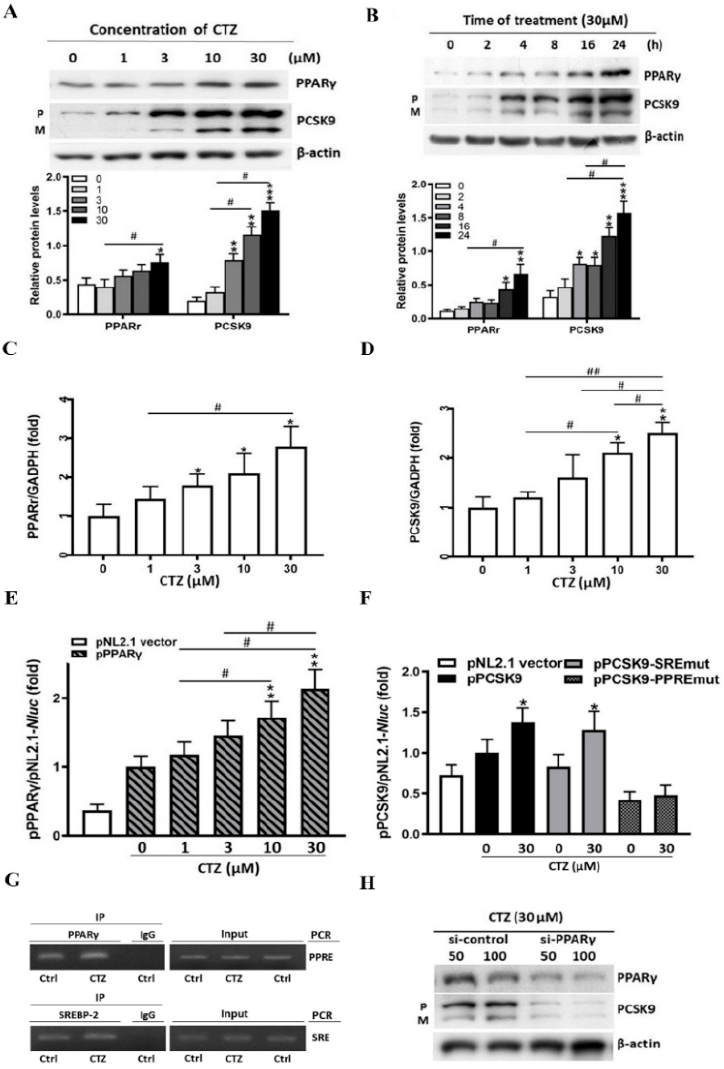
Figure 1. Cilostazol activates the expression of peroxisome proliferator-activated receptor- γ (PPAR γ ) and proprotein convertase subtilisin/kexin type 9 (PCSK9) in HepG2 cells. * p < 0.05, ** p < 0.01, and *** p < 0.001 versus the untreated group. # p < 0.05, and ## p < 0.01, comparison between treated groups. ( A ) HepG2 cells in serum-free medium were treated with cilostazol at different